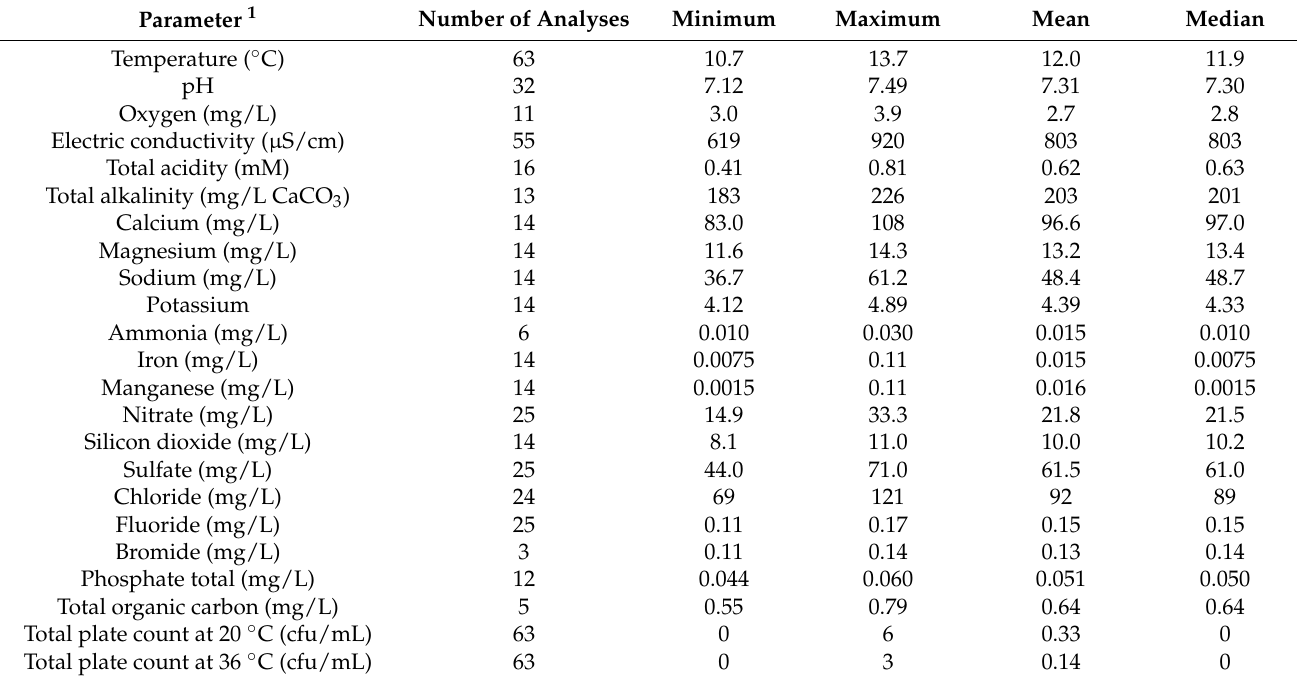
Table 2. Chemical composition and main properties of the raw